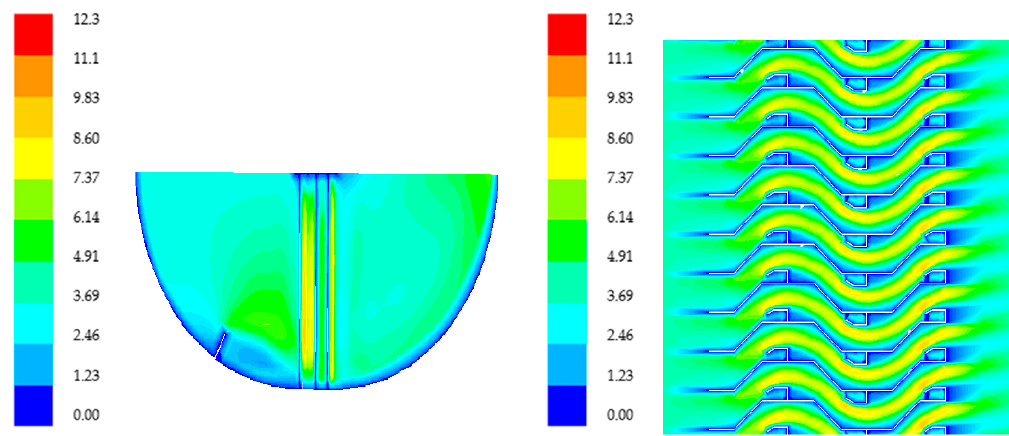
Figure 3. Velocity field distribution of the separator in di ff erent directions, m / s. ( a ) Longitudinal section. ( b ) Cross section.